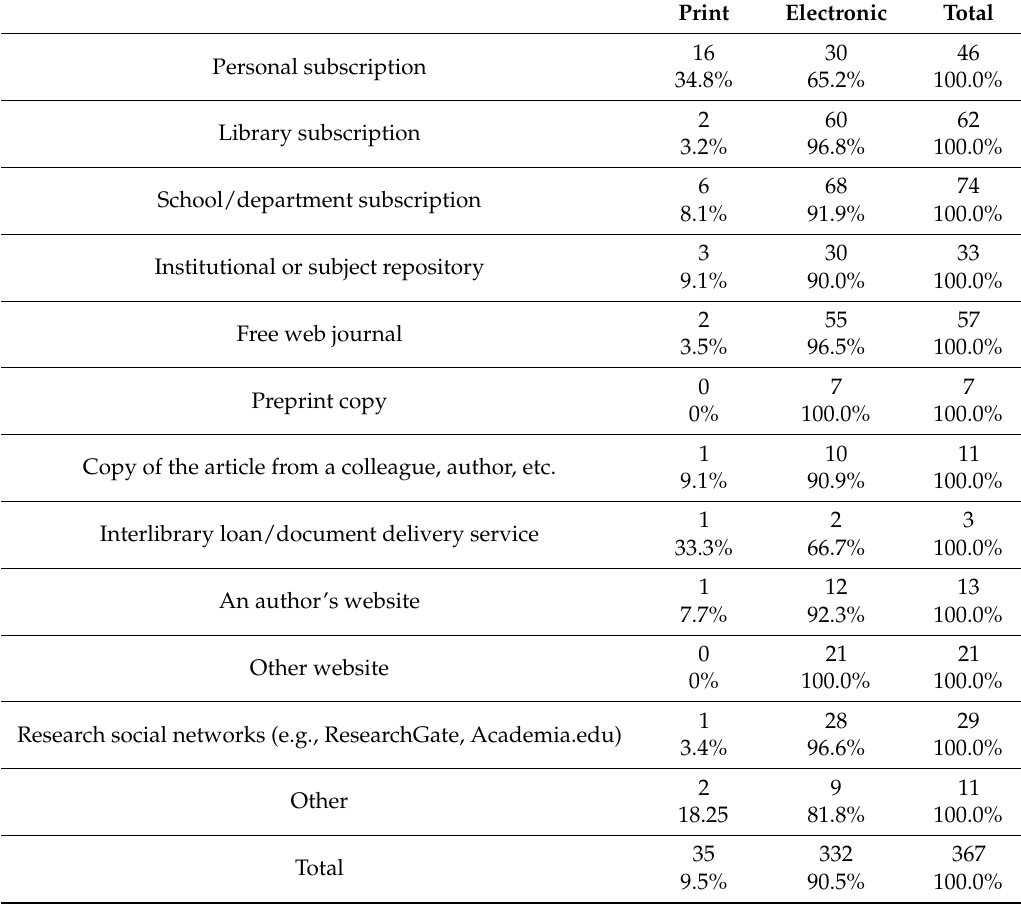
Table 17. From where respondents obtain article readings (by